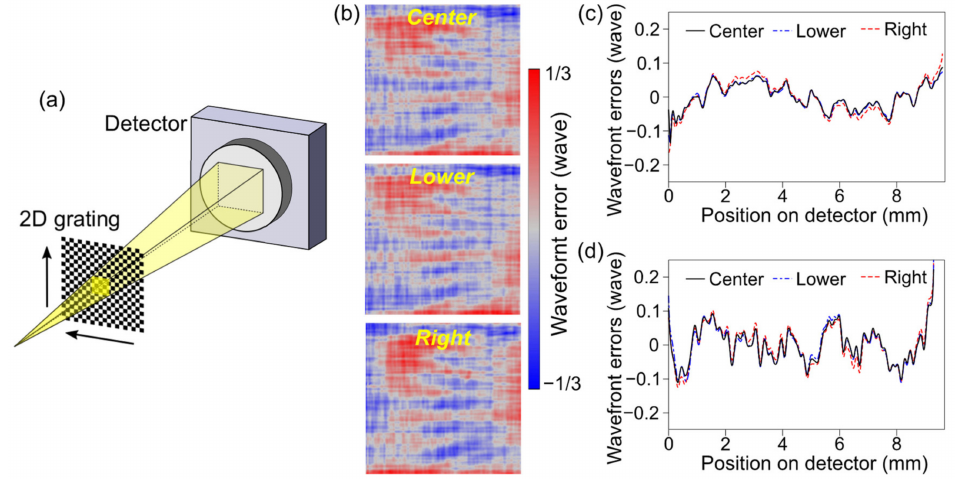
Figure 3. Dependences of illumination area on the 2D grating. ( a ) Schematic drawing of the measurement setup. The 2D grating was laterally shifted with a 300 µ m step in the horizontal and vertical direction. ( b ) 2D results of the wavefront errors measured using center (top), lower (middle), and right (bottom) area of the grating. ( c , d ) Averaged profiles in the horizontal ( c ) and vertical ( d ) directions.